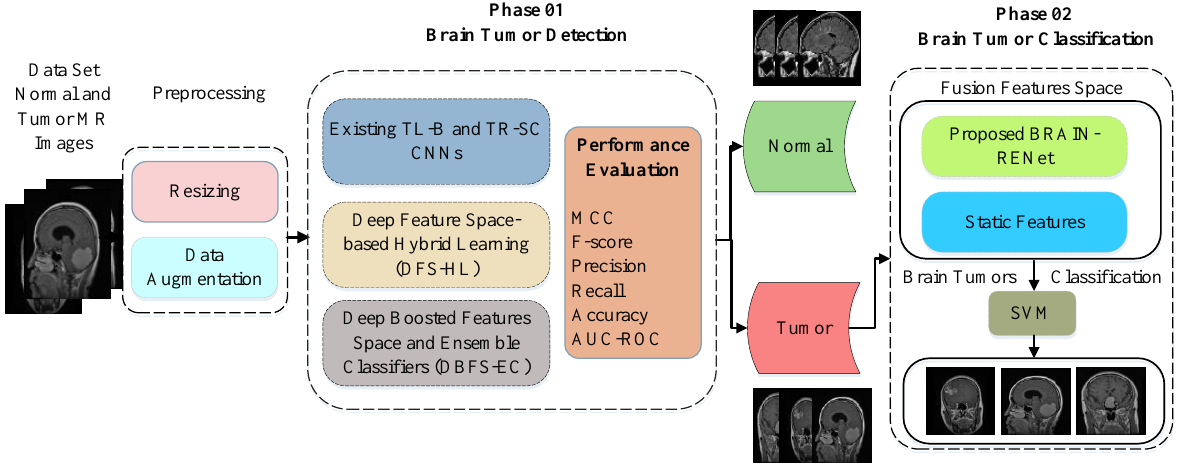
Figure 1. Overall description of the proposed two-phase brain tumor analysis framework.